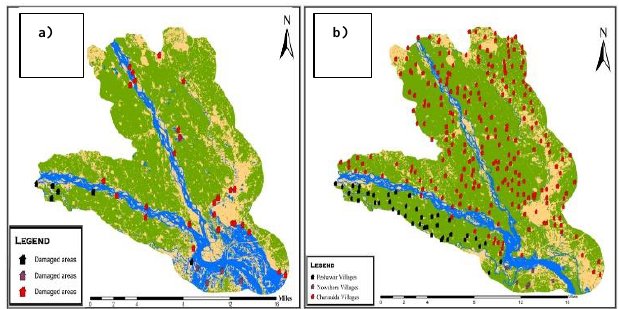
Figure 5: (a) Represent pre-flood classified map of settlements of district Charsadda, (b) shows a classified map of settlements damaged during the flood in the study area.